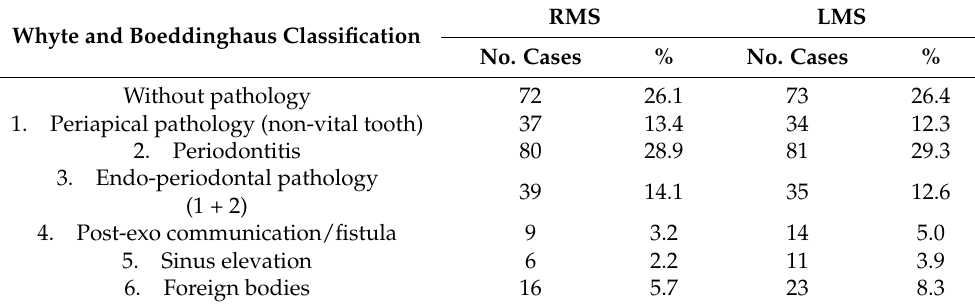
Table 5. Distribution according to the Whyte and Boeddinghaus classification by number of cases and percentages.